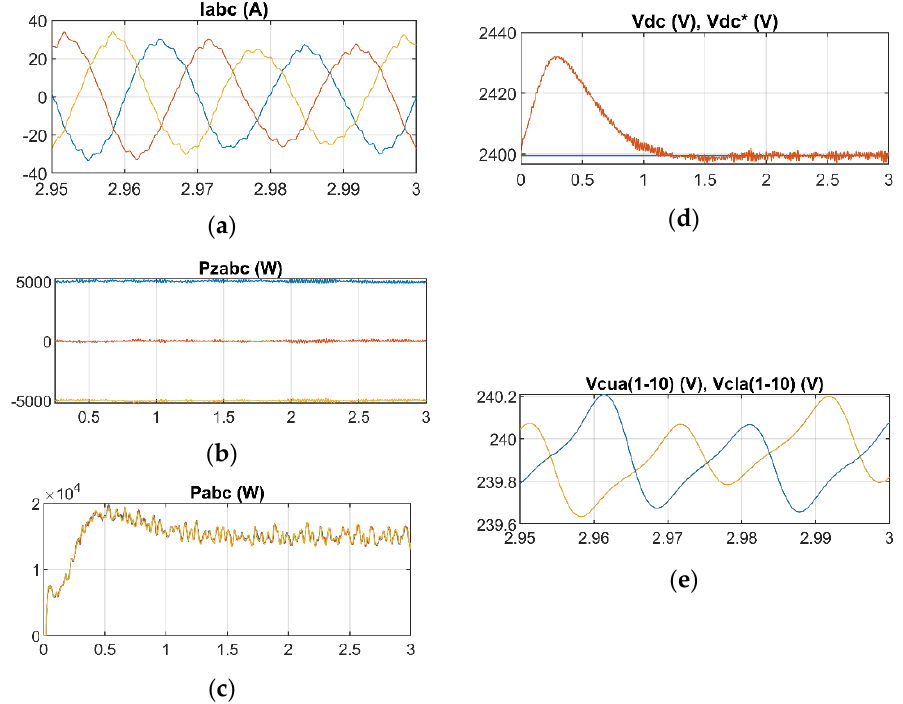
Figure 9. Simulation graphs when the generation has a medium phase imbalance. ( a ) Output currents. ( b ) Power transferred between phases. ( c ) Power delivered by each phase. ( d ) Voltage on the DC link. ( e ) Capacitor voltages.